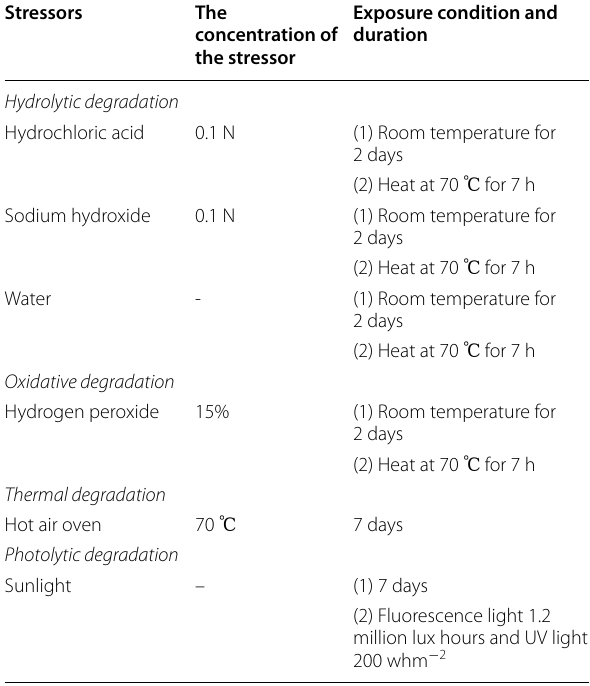
Table 1 Stress conditions for the degradation study of felbamate Stressors The concentration of the